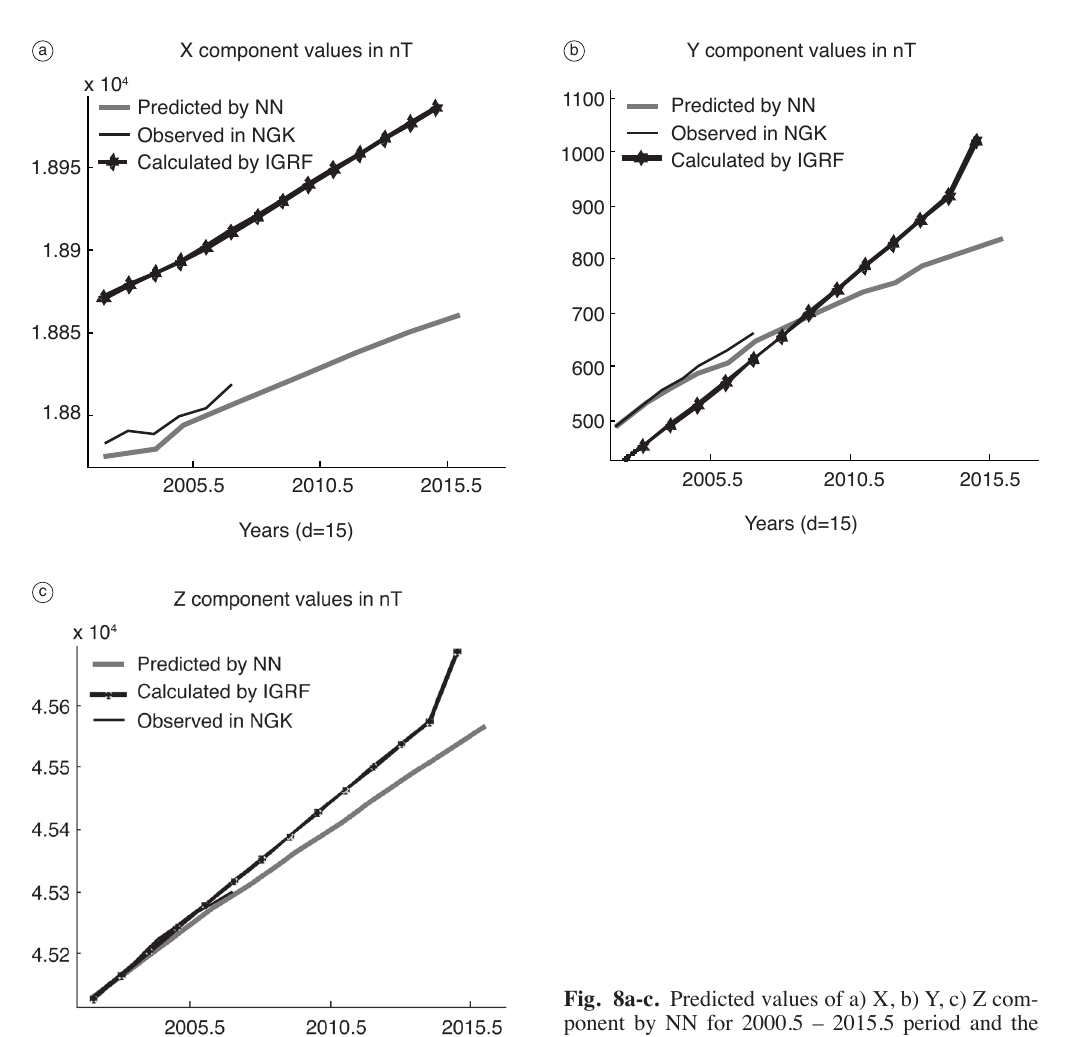
Fig. 8a-c. Predicted values of a) X, b) Y, c) Z com- ponent by NN for 2000.5 – 2015.5 period and the respective values calculated by Gufm1 model and observed on NGK